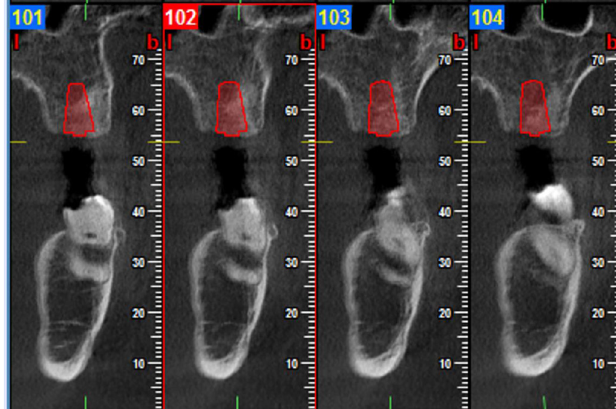
Fig. 6. Pre-implant CBCTexamination. NNT Viewer software (NewTom, Verona, Italy) allowed to visualize implant in the alveolar ridge and to determine orientation, diameter and length of the proposed implant. A 6 (cid:3) 10mm implant (Zimmer Dental Trabecular Metal®) was chosen. Trabecular bone appeared loose. Bone hypertrophic abnormalities were notable on the lingual side of the mandibule.